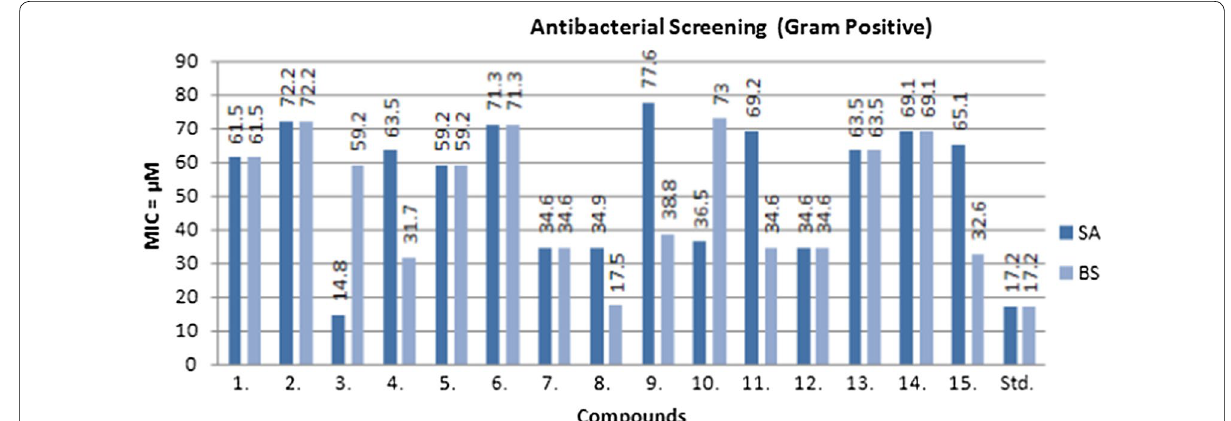
Fig. 3 Antibacterial screening results against Gram positive species